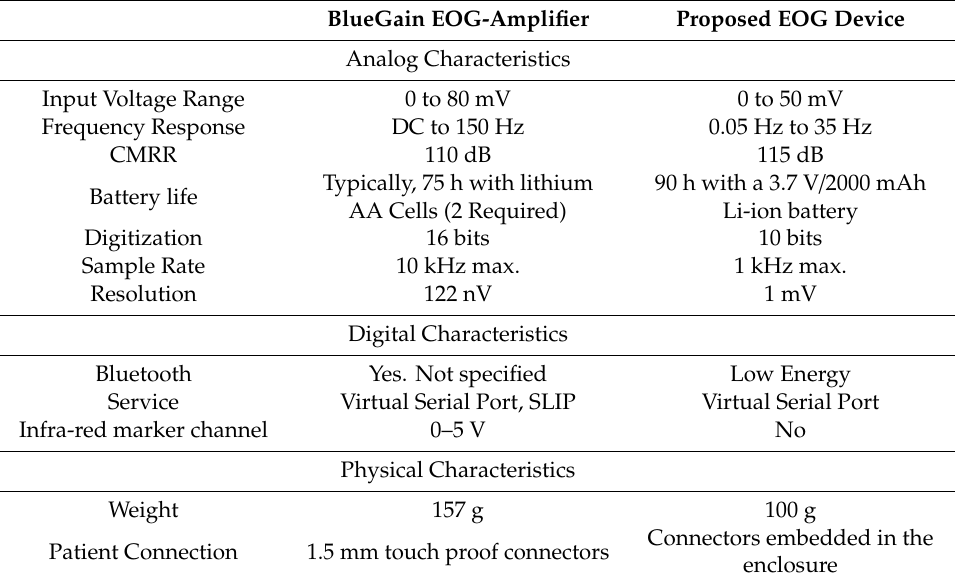
Table 1. Comparison of characteristics between the BlueGain Amplifier and the proposed